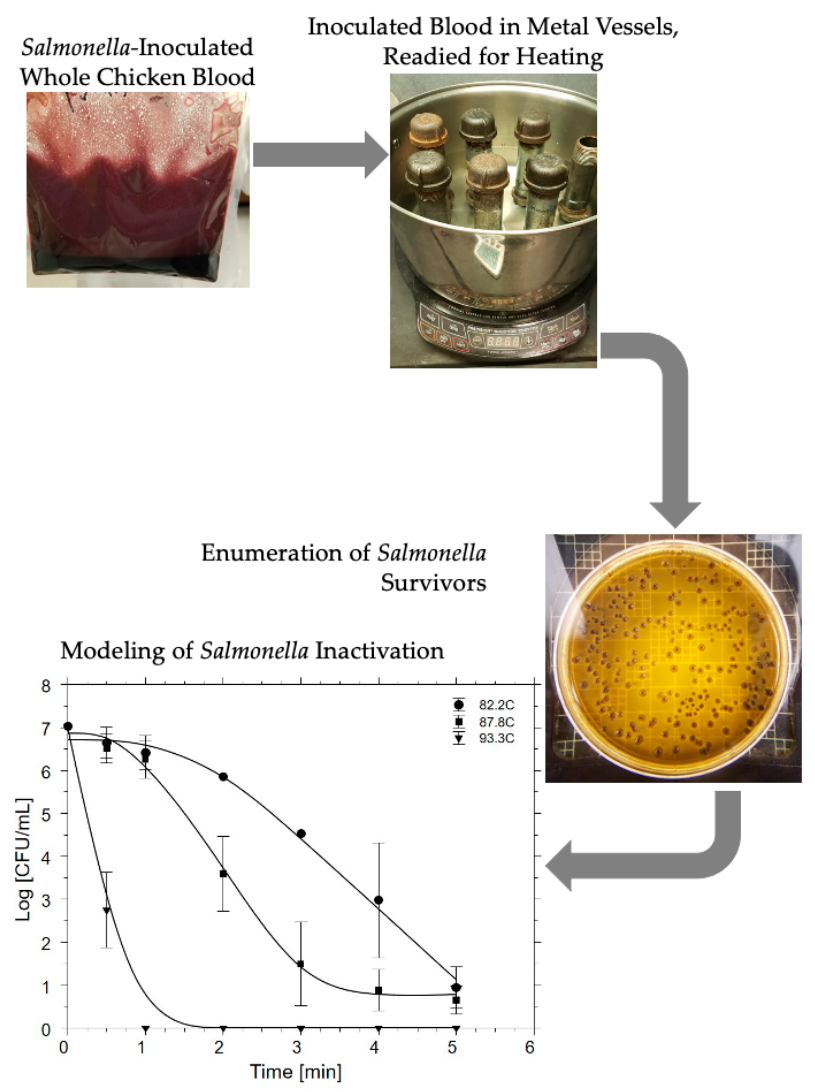
Figure 1. Flow process depiction of Salmonella lethality determination from heating of pathogen-inoculated whole chicken blood.